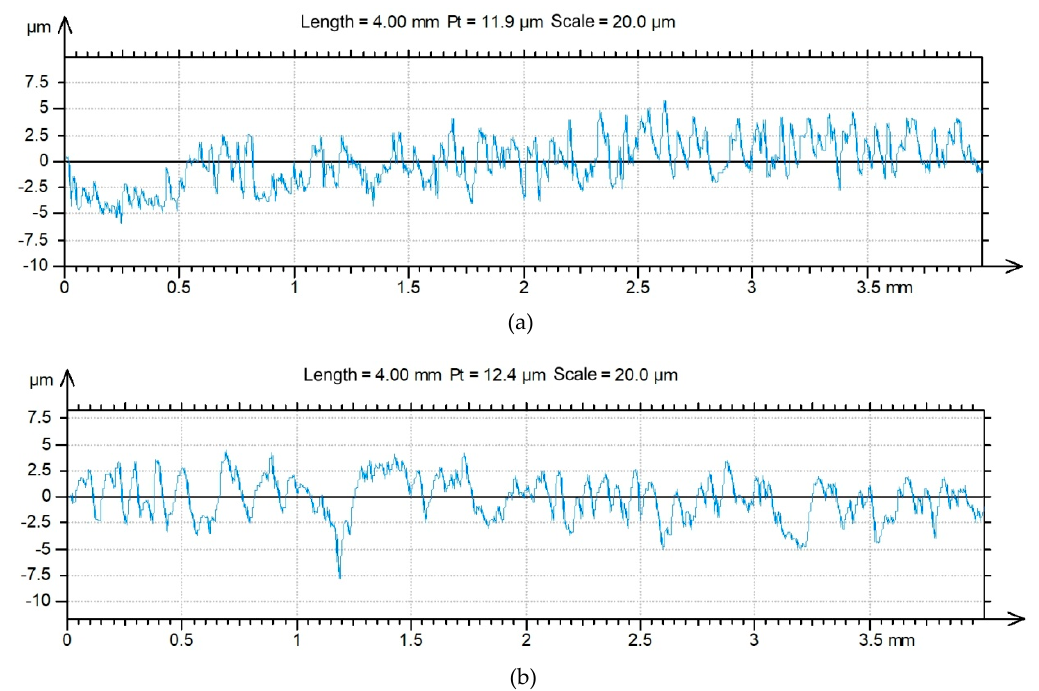
film, measured for the specimen along the ( a ) longitudinal and ( b ) transverse directions.